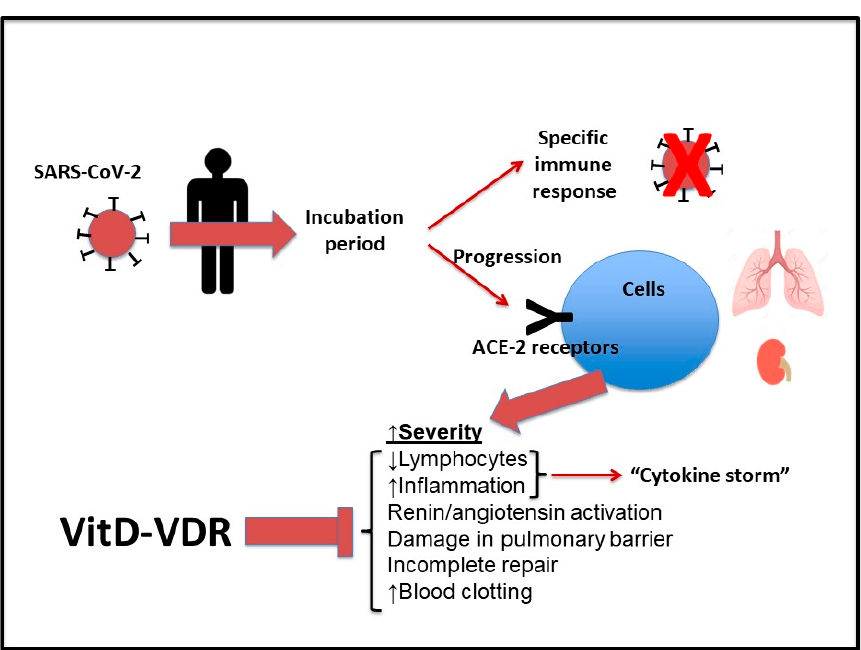
Figure 1. Scheme of the proposed role of vitamin D during SARS-CoV-2 infection. An incubation phase occurs when the virus enters the body. If the host produces a specific immune response, the virus is eliminated. If the host immune system cannot eliminate the virus, this can infect tissues with ACE-2 receptors (lungs and kidneys). The result is an increase in the severity of the disease. Vitamin D-VDR complex may attenuate the symptoms decreasing progression of COVID-19. ( ↑ ) Indicates activated process/increased number ( ↓ ): Decreases.